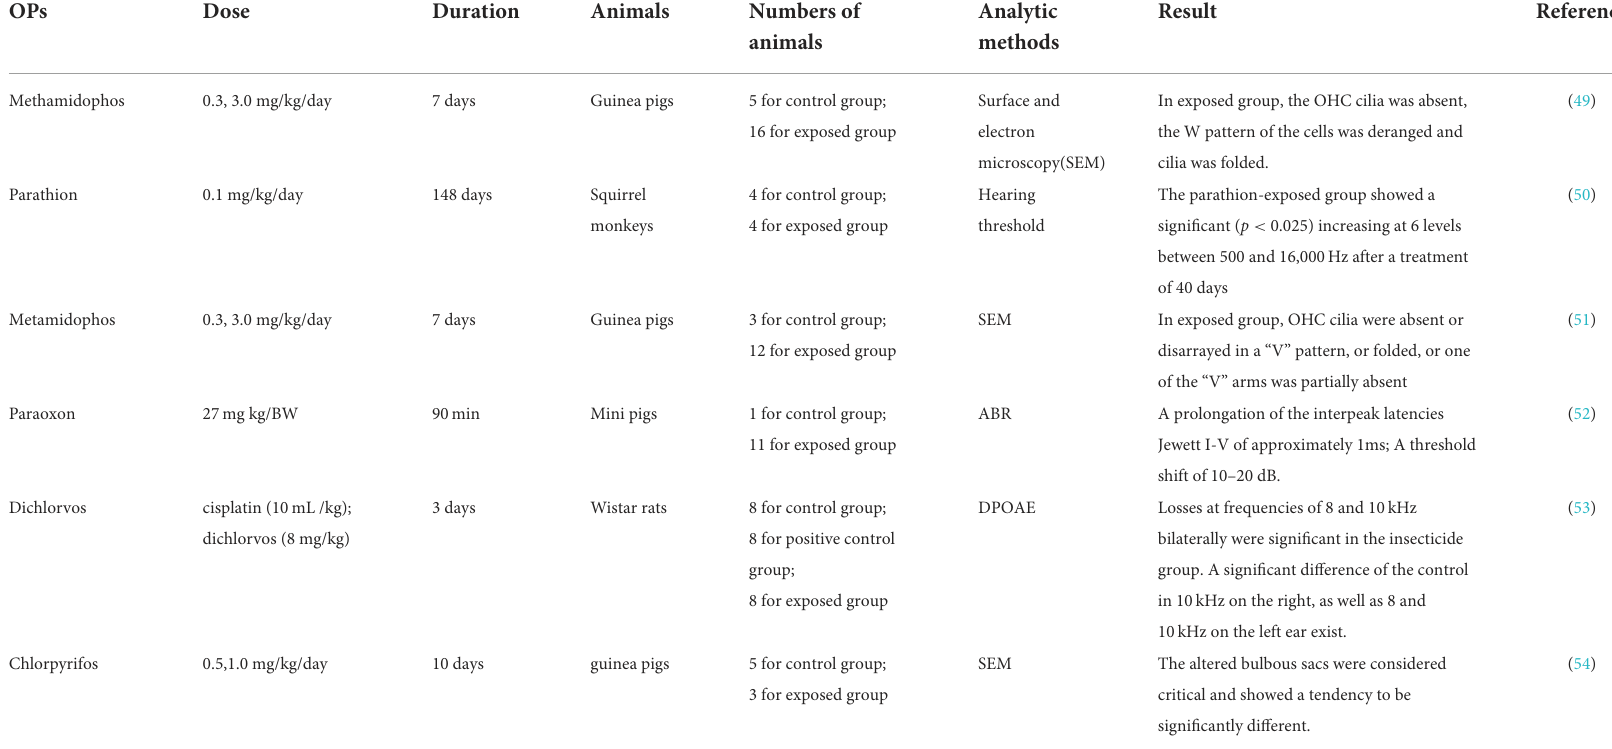
TABLE 2 Experimental animal studies on the effects of exposure to organophosphorus persticides (OPs) on animal auditory